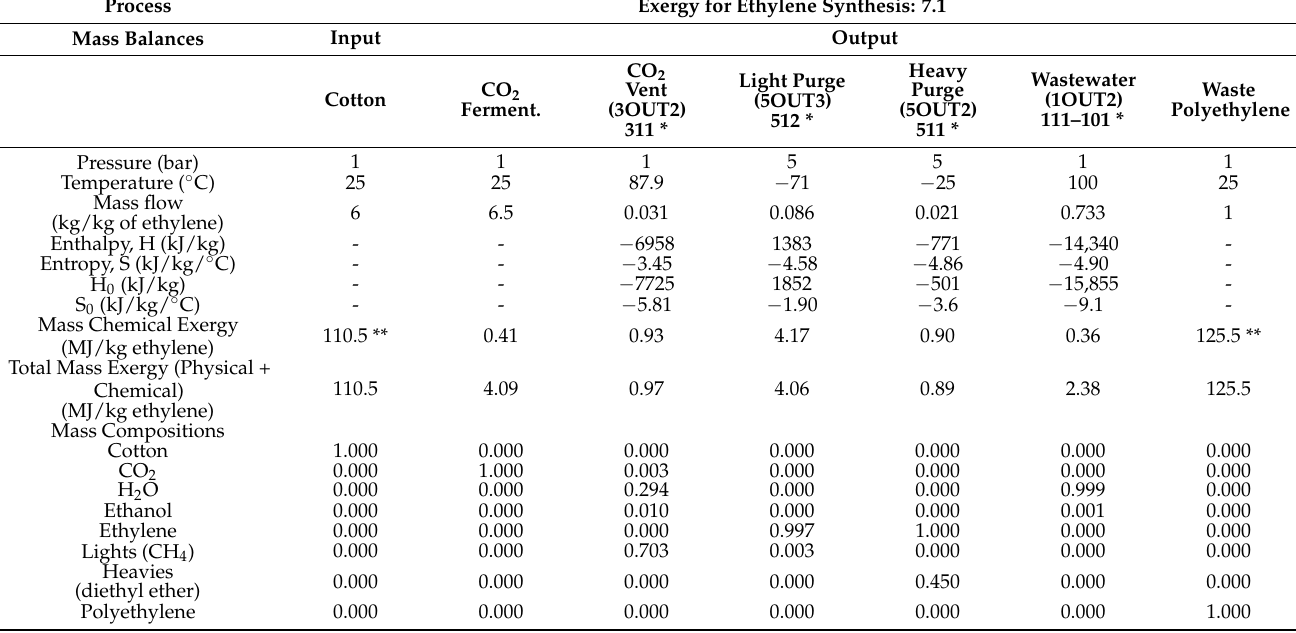
Table 1. Exergy analysis of cycle streams for cotton fermentation and polyethylene